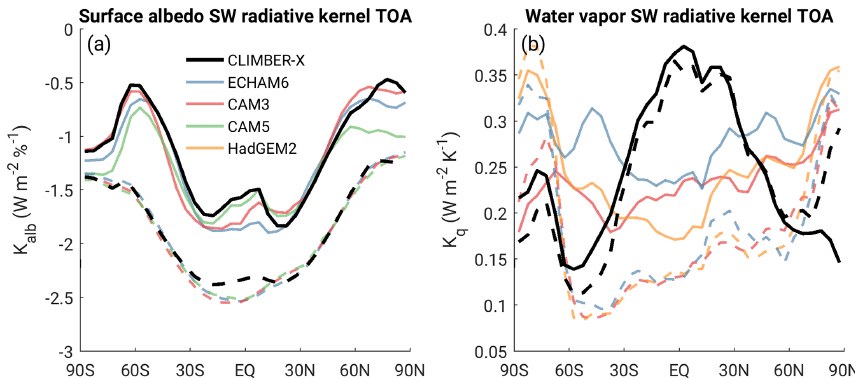
Figure A3. Shortwave radiative kernels at the top of the atmosphere for (a) a 1% increase in surface albedo and (b) water vapour increase corresponding to a 1K warming of the atmosphere. The kernels computed using the CLIMBER-X radiation code are compared to kernels available from different climate models (Shell et al., 2008; Block and Mauritsen, 2013; Smith et al., 2018; Pendergrass et al., 2018). Solid lines are for total-sky conditions, while dashed lines are for clear-sky